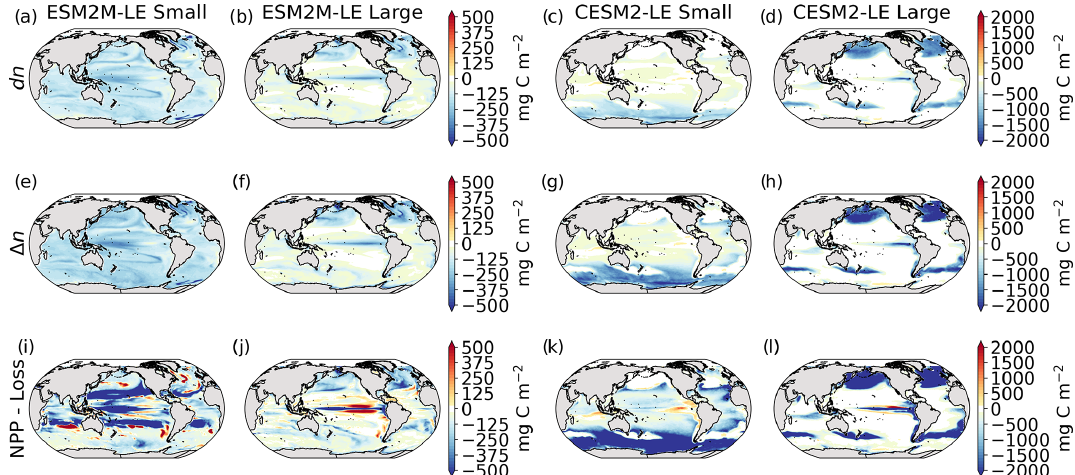
Figure 5. Biomass anomaly d n (mgCm − 2 ) of small and large phytoplankton during compound MHW–NPPX events in ESM2M-LE (a, b) and in CESM2-LE (c, d) . Integrated biomass change (cid:49)n (mgCm − 2 ) leading to the maximum anomaly reached during a compound MHW– NPPX event (e–h) . Contribution of biological processes (NPP − Loss, i–l ) to (cid:49)n